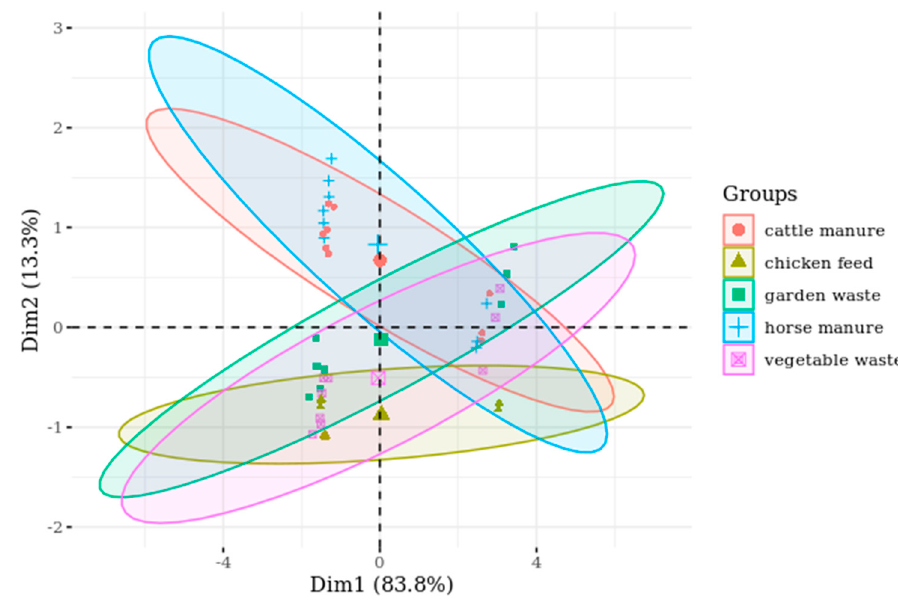
Figure 6. PCA biplot representing larval ash concentration dependency on the rearing substrates.